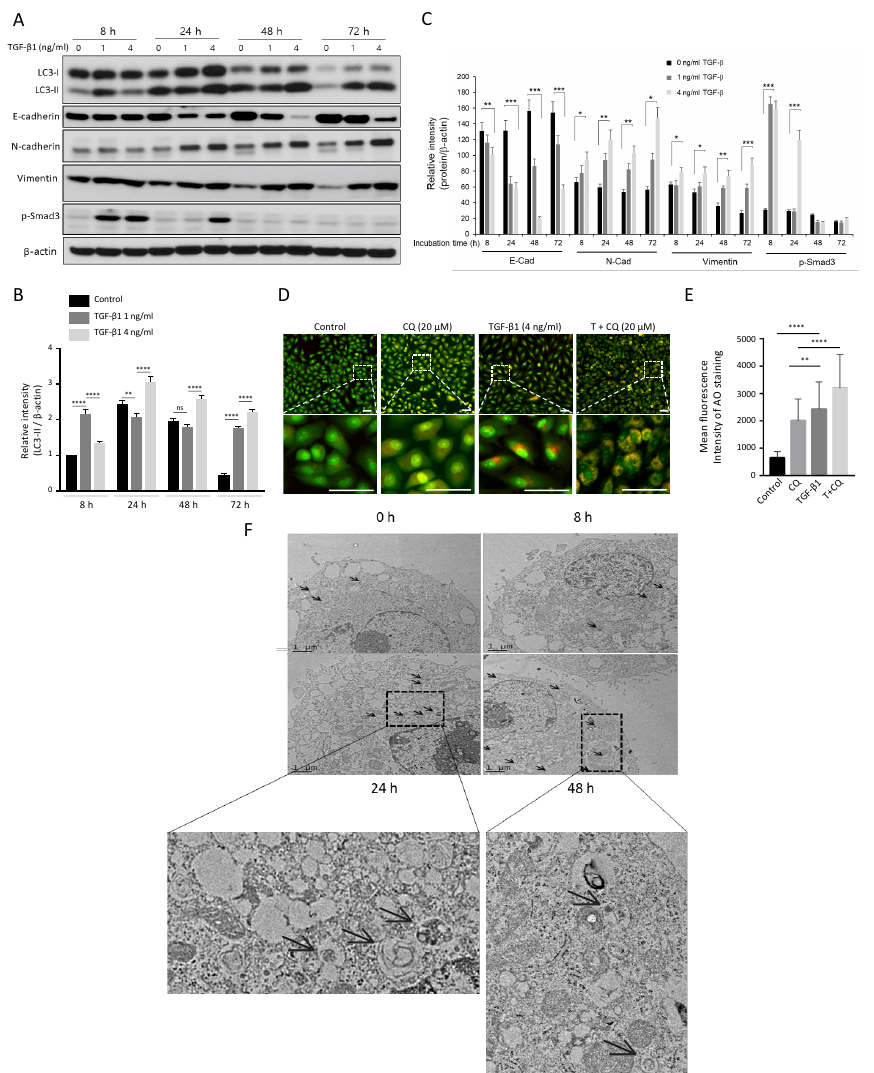
Figure 2. The activation of autophagy is involved in TGF- β 1-induced EMT. ( A ) Western blotting. A549 cells were treated with the indicated concentrations of TGF- β 1 (0–4 ng/mL) for 8 h, 24 h, 48 h, and 72 h. EMT markers (E-cadherin, N-cadherin, Vimentin, phosphorylated Smad3 (Ser423/425)) and LC3 proteins were detected using their primary antibodies. β -actin was used as a loading control. ( B ) Relative intensity of LC3-II. The relative LC3-II values to LC3-I were quantified using ImageJ software and normalized by β -actin. Data indicate the mean values ± s.d of at least three independent experiments. ( C ) Relative intensity of other EMT markers. The relative values for each EMT marker protein (E-cadherin, N-cadherin, Vimentin, phosphorylated Smad3 (Ser423/425)) were normalized by β -actin. ( D ) AO staining assay. Acridine orange dye stained acidic vehicles of A594 cells incubated with indicated treatments: TGF- β 1 4 ng/mL, 20 µ M Chloroquine. The bottom images were magnified from the dotted rectangle area. ( E ) The mean fluorescence intensity of AO staining was quantified from at least three independent experiments using the ImageJ program. Scale bar in upper and bottom, 50 µ m. ( F ) Transmission electron microscopy (TEM) of A549 cell in treatment with 4 ng/mL of TGF- β 1 for 0, 8, 24, 48 h. Autophagosomes and autolysosomes are indicated with black arrows. The bottom images were magnified from a specific area. * p < 0.05, ** p < 0.01, *** p < 0.00, **** p < 0.001 compared to